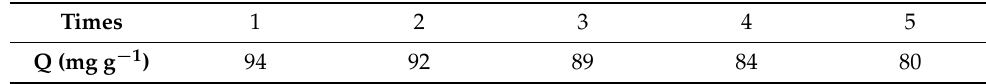
Table 7. Repeated use of MIP on adsorption capacity.